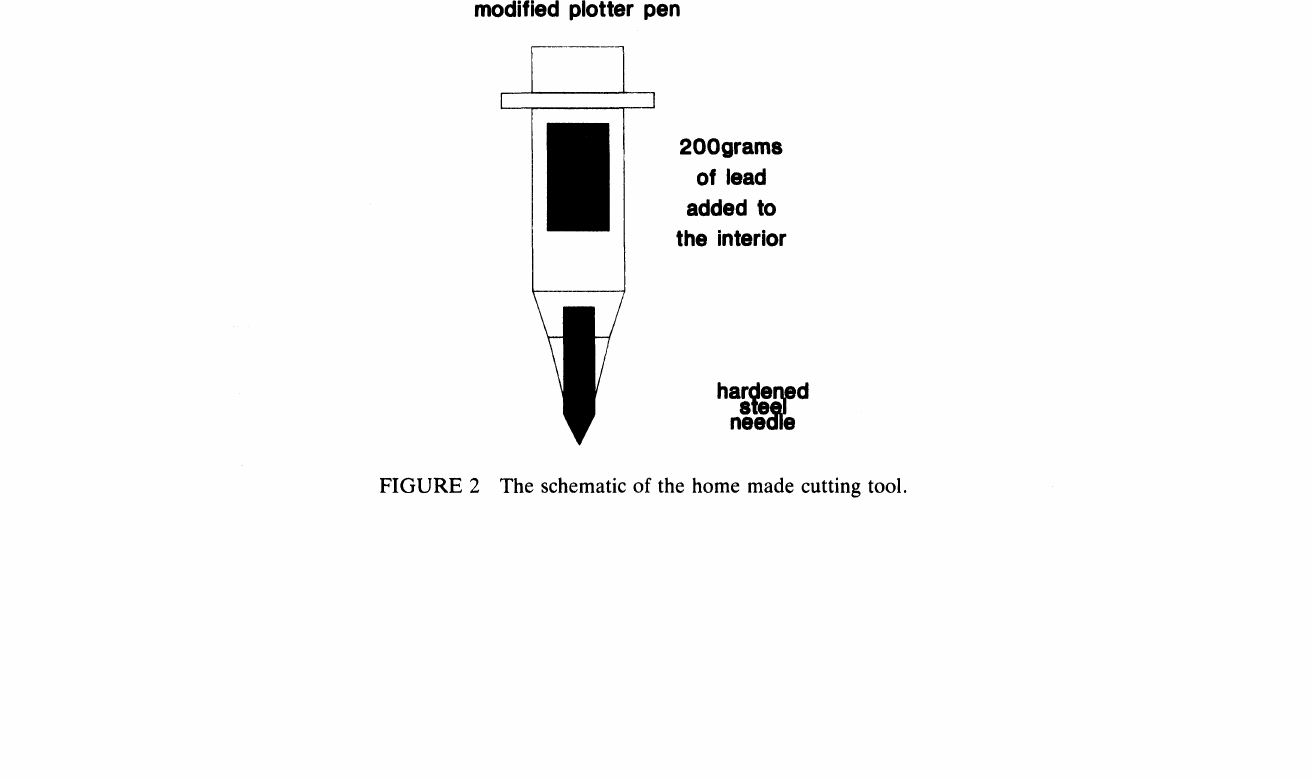
FIGURE 2 The schematic of the home made cutting